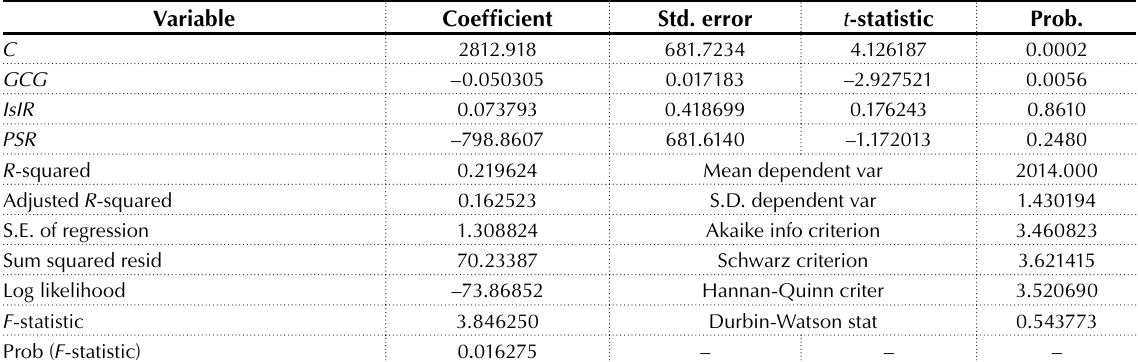
Table 3. Regression results using the FE model